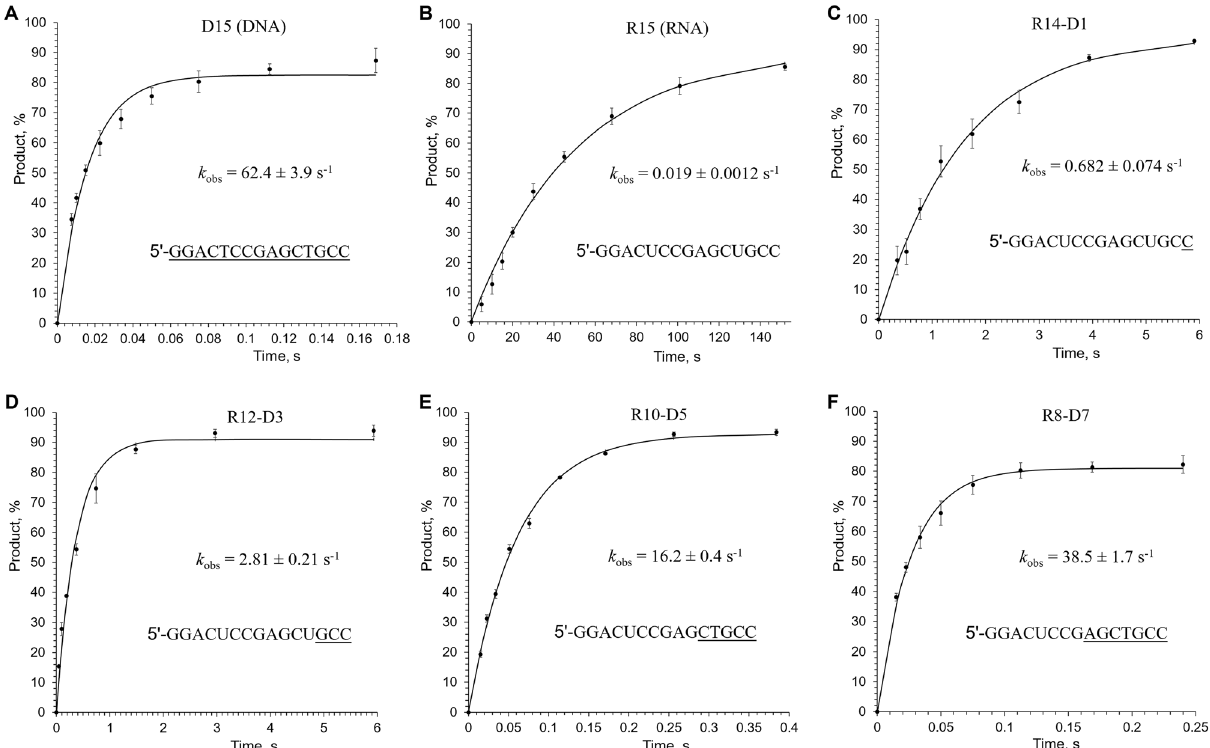
Figure 4. Effect of primer structure on its extension by hPolε CD . Activity of hPolε CD in extension of a DNA primer ( A ), an RNA primer ( B ), and chimeric RNA–DNA primers with one ( C ), three ( D ), five ( E ), and seven ( F ) deoxynucleotides at the primer 3 ′ -end was analyzed. Primer sequences are indicated on the graphs; DNA stretches in chimeric primers are underlined. Percentage of extended primer was plotted against time and the data fit to a single-exponential equation (1). Reactions, containing 0.44 µM hPolε CD , 0.2 µM template:primer, and 1 mM dTTP, were incubated at 35 °C at the indicated time points. The mean k obs values and standard deviations were calculated from three independent experiments using GraphPad Prizm